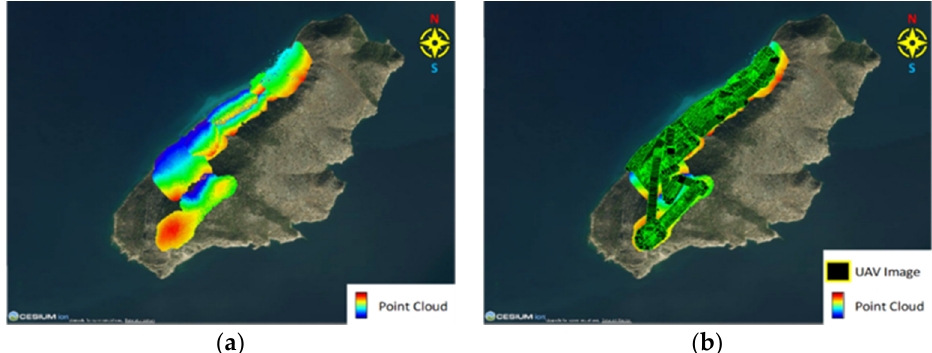
Figure 24. Illustrations of the base map and ( a ) UAV LiDAR point cloud overlaid with ( b ) UAV images in the Potree web-visualization portal.